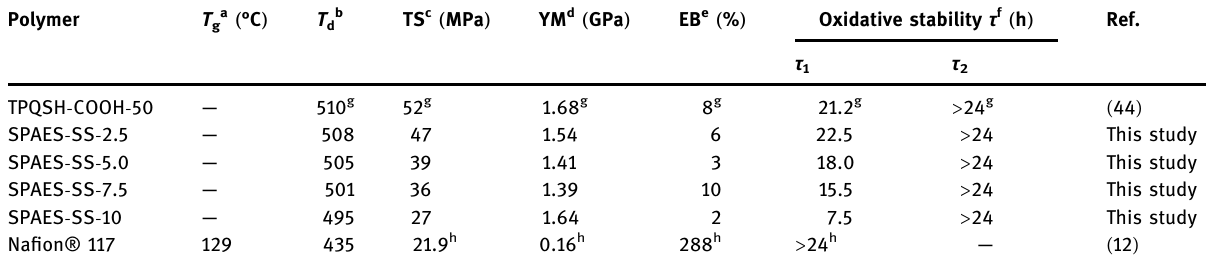
Table 1: Thermal, mechanical, and oxidative stability of SPAES - SS - X membranes as well as selected reference polymers Polymer T ga ( °C )